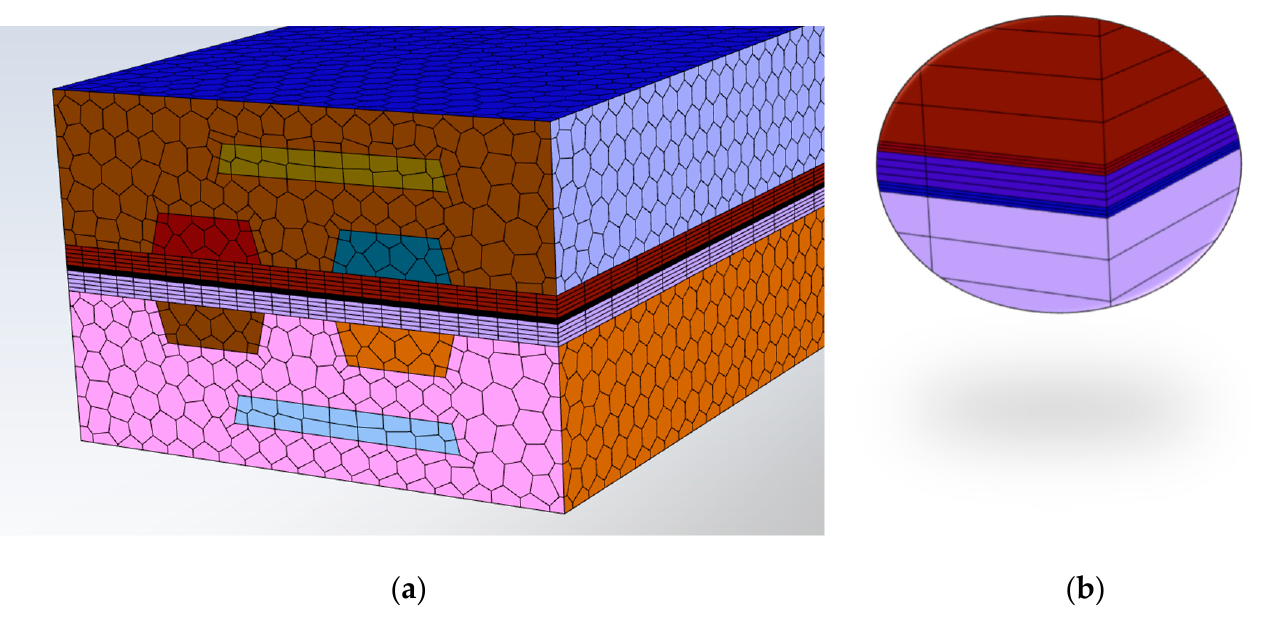
Table 2. Material parameters and boundary conditions of model.